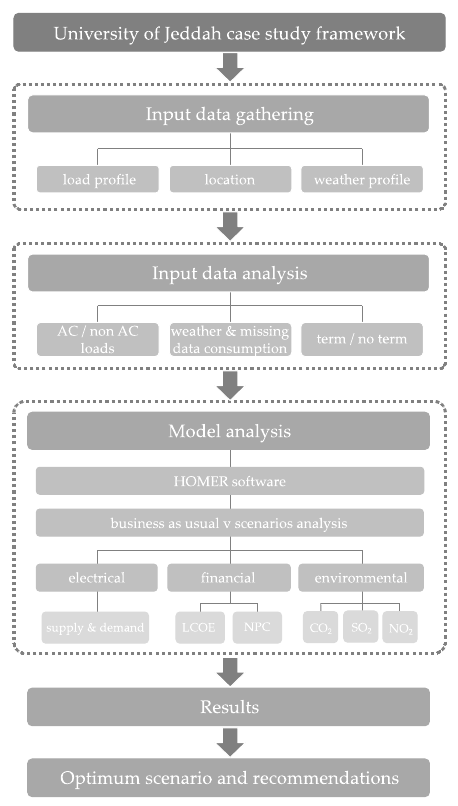
Figure 1. University of Jeddah Campus Latitude (N): 21.89252 degrees, Longitude (E): 39.2539 de- grees (image source Google Maps 2021).